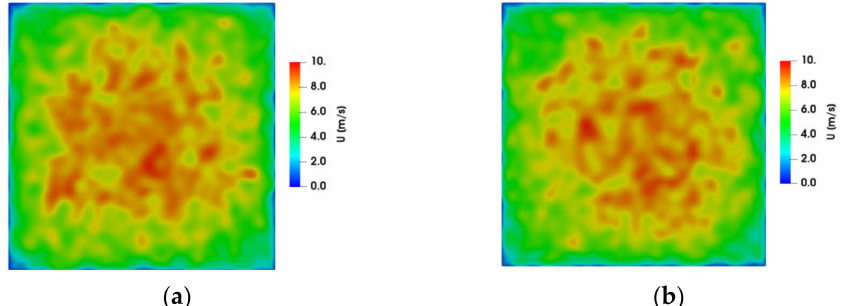
Figure 10. The two instances of inlet boundary conditions based on the digital filtered method [46] at: ( a ) 1 sec; ( b ) 2 sec.